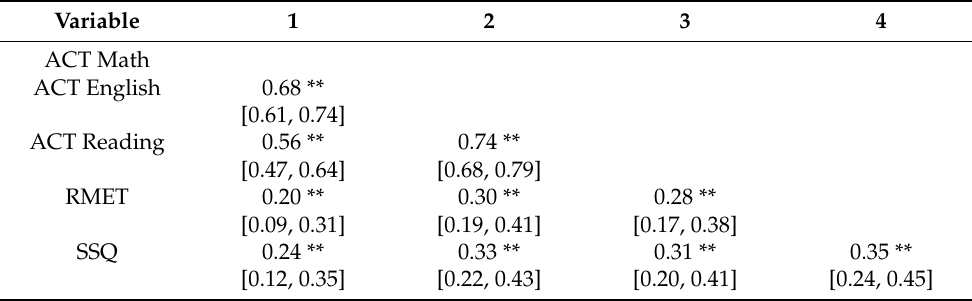
Table 2. Correlations with confidence